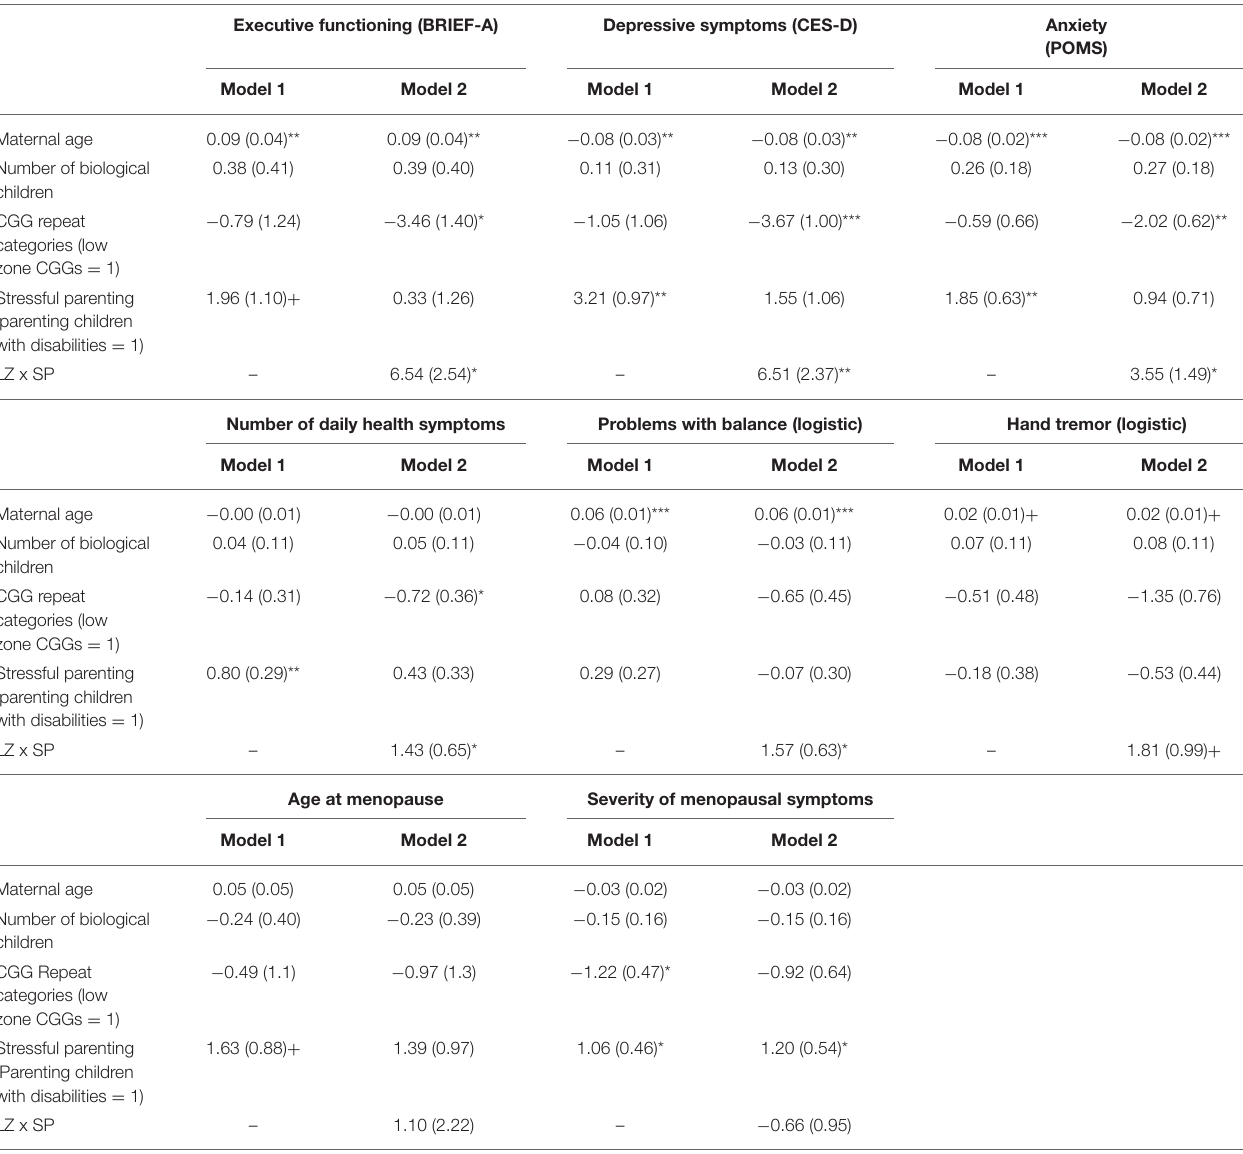
TABLE 3 | GEE (Generalized Estimating Equations linear unless noted as logistic) models predicting phenotypes by stressful parenting and CGG repeat categories: mothers a